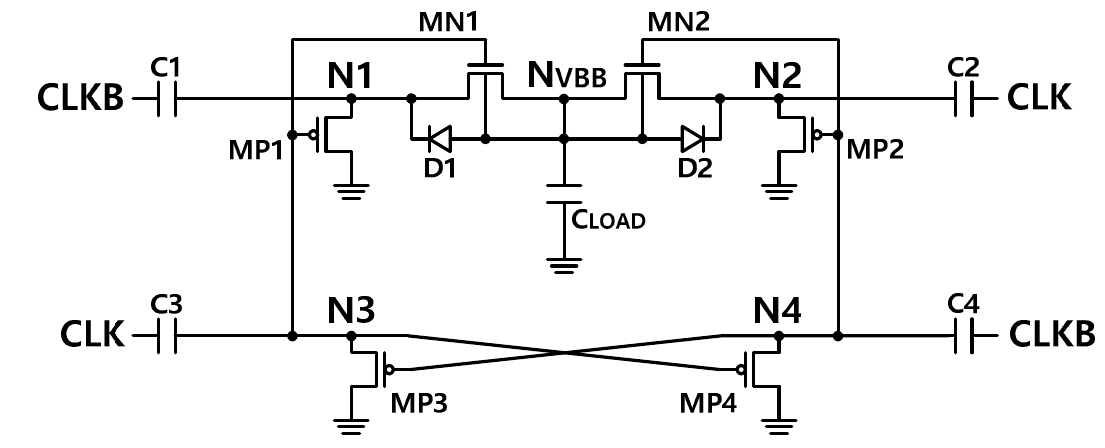
Figure 3. Conventional cross-coupled hybrid pumping circuit (Conv 2) [5]. Table 2. Sequential operation of Conv2.